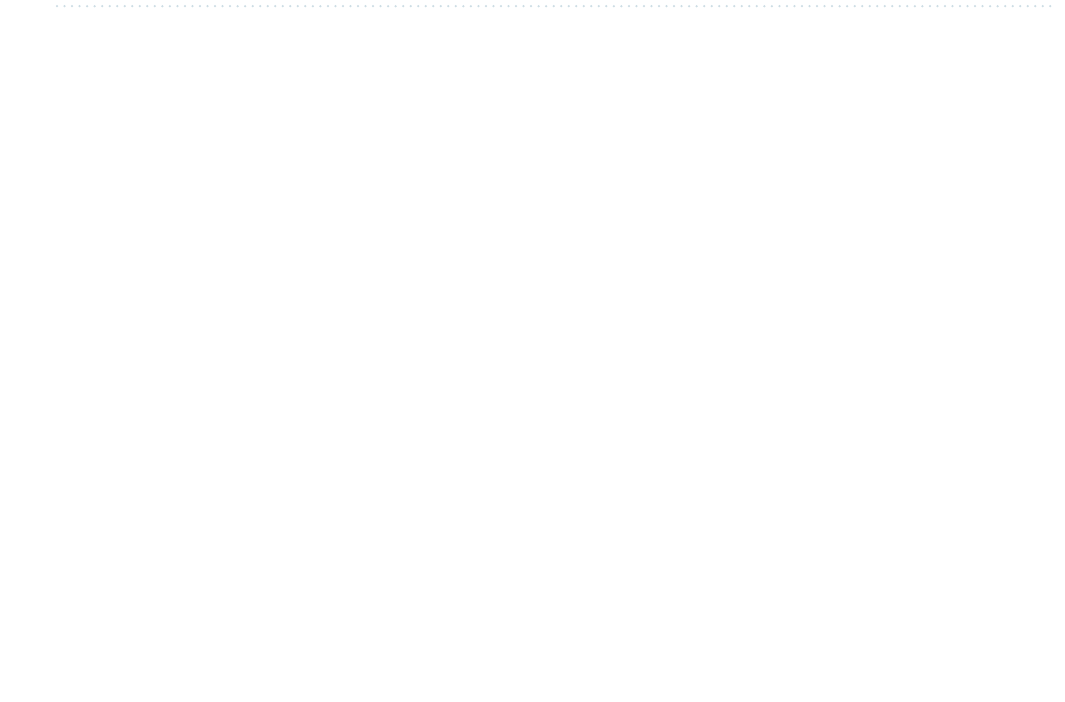
Figure 5. Astigmatism on the double angle plot 24 months post-op in PC. The trend is ATR. The yellow dots represent a single subject’s